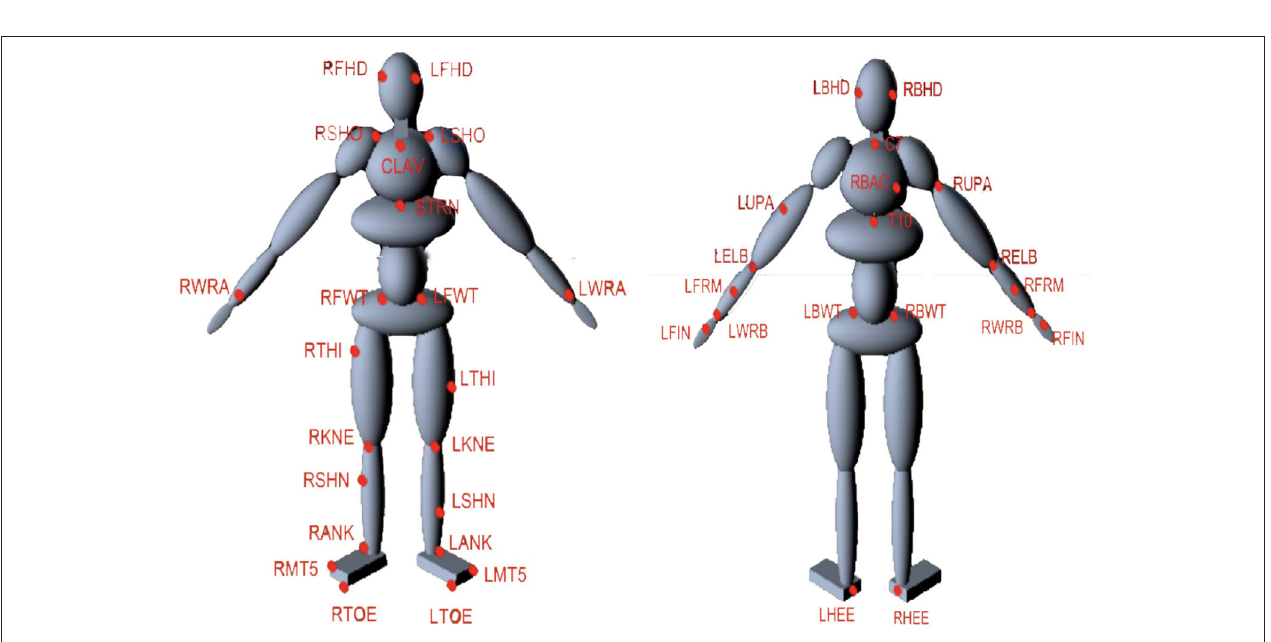
FIGURE 2 | Marker arrangement on the HDM. The suit contains 51 markers as shown by the LEDs in total but only 41 are used in the model, e.g., Markers that are unused are present on the fingers. Markers can easily assigned to specific model segments. For example, the markers of RBHD, RFHD, LFHD, and LBHD are assigned to Head segment while the markers of RBWT, RFWT, LFWT, and LBWT belong to Pelvis